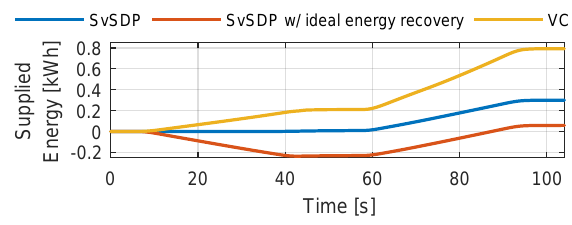
Figure 19: Supplied input energy during a trajec- tory. The shown SvSDP curves are evaluated using the energy efficient input transformation.